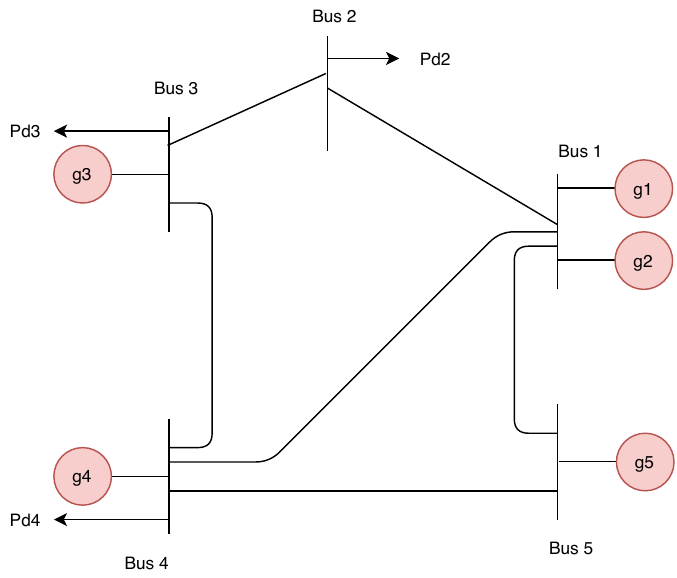
Figure 2. Schematic diagram of a 5-bus